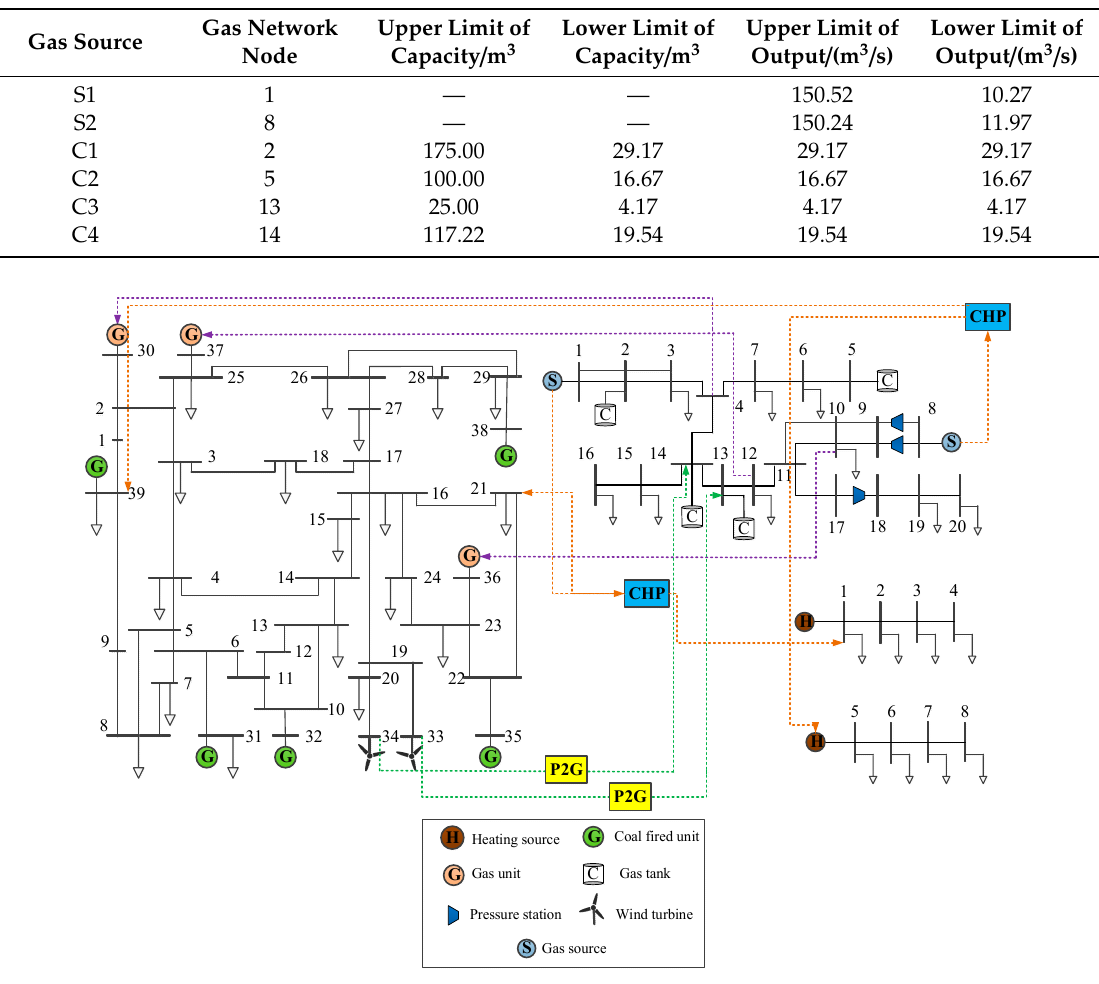
Figure A1. The structure of Example System 1.